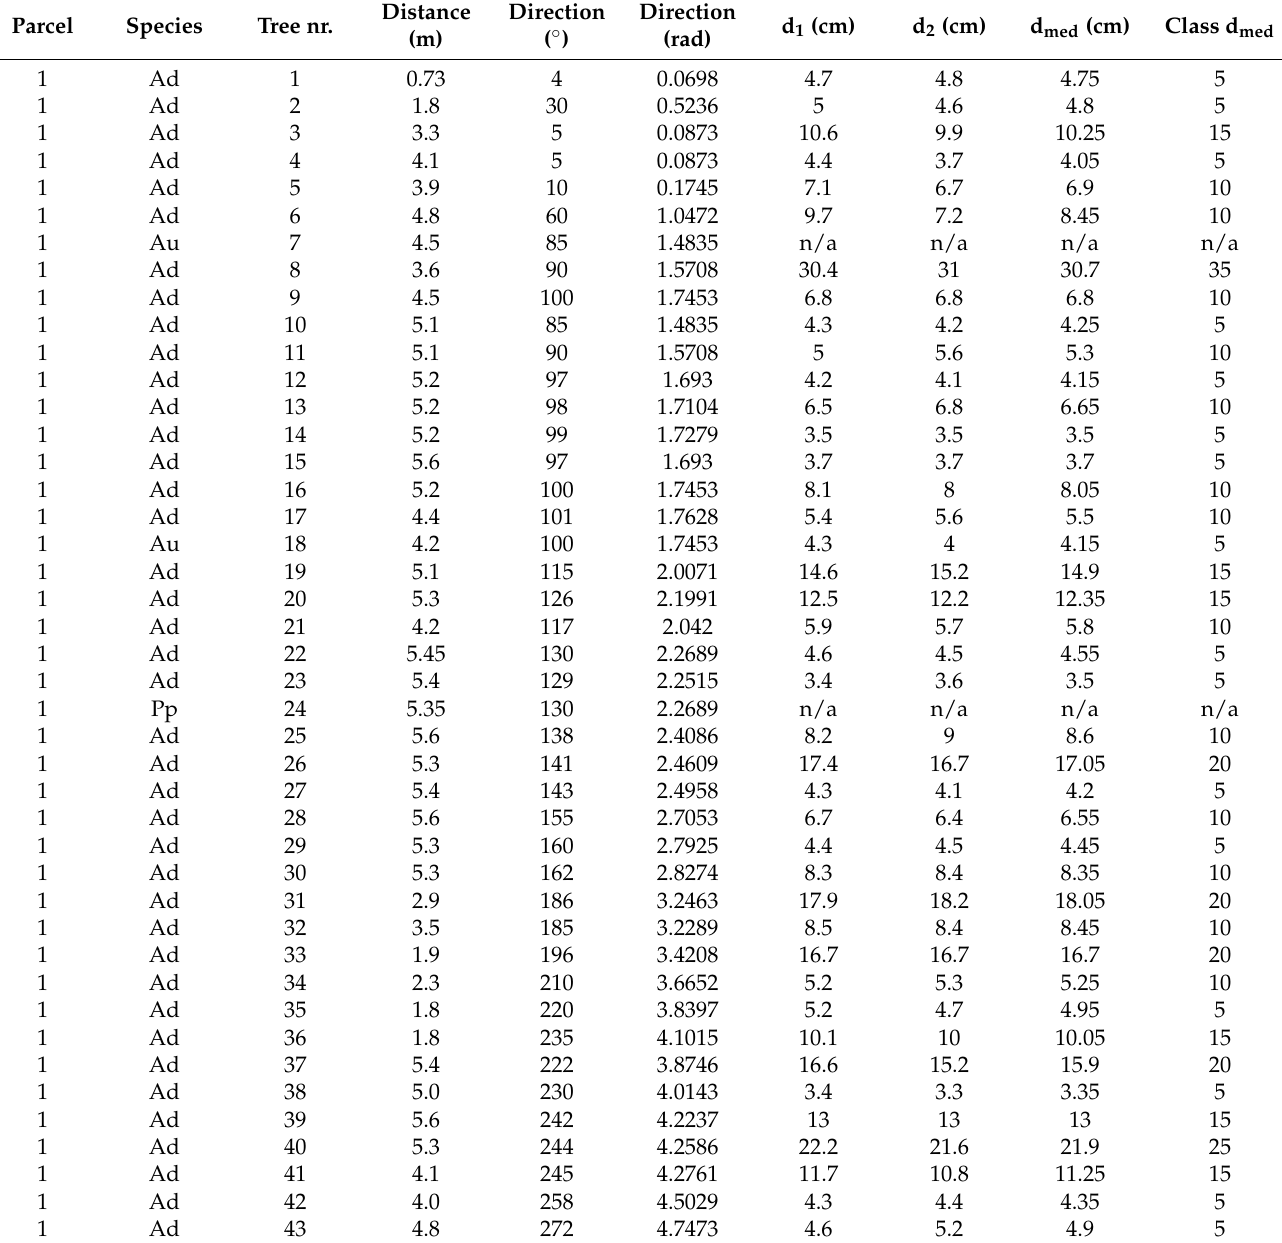
Table 1. Data collected in Parcels 1 and 2 (Ad— Acacia dealbata ; Au— Arbutus unedo ; Pp— Pinus pinaster ; n/a—not